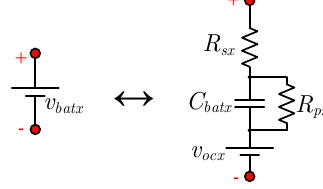
Figure 2 . Thevenin battery model for each EV x . Table 1. Simulation parameters of the EV-BCS and EV